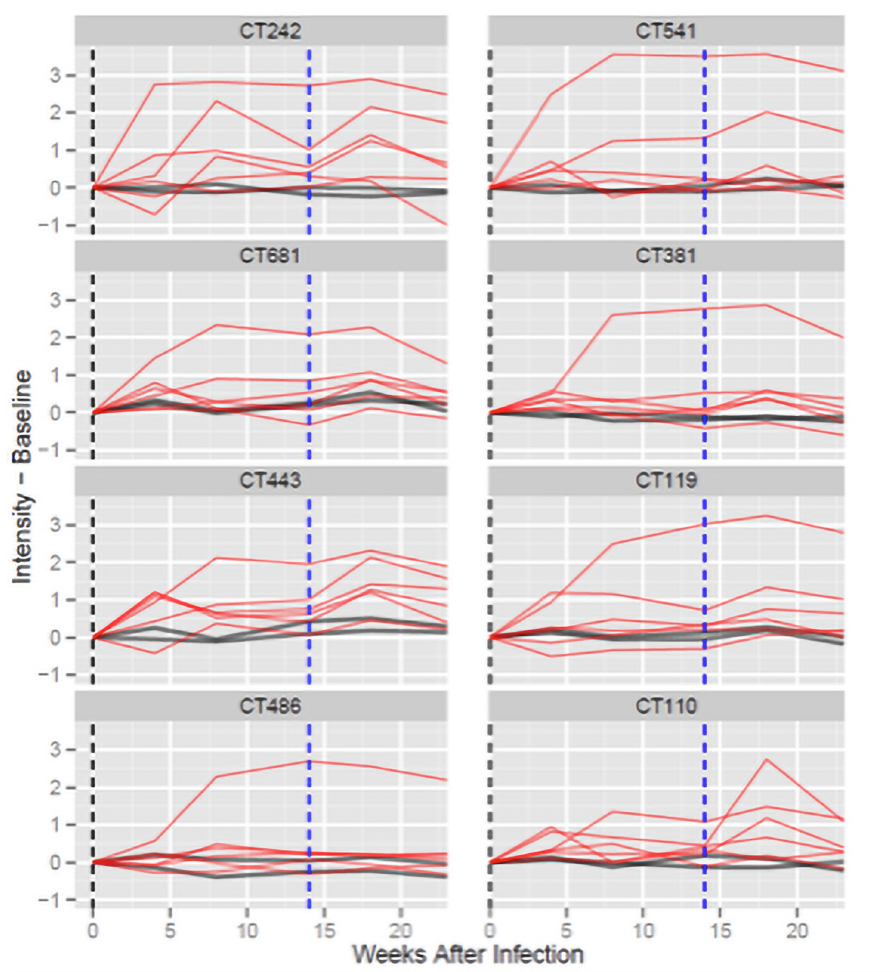
Fig 4. Time course of antibody responses from week 0 to week 23. Each panel presents the time course of antibody responses for one reactive antigen (six monkeys infected at weeks 0 and 14 and mock controls). The x-axis shows the weeks since infection and the y-axis presents the normalized intensity after subtracting the week 0 intensity for each monkey. Infected monkeys are shown with red lines and mock control monkeys are shown with dark gray lines. Vertical dashed lines indicate the first (black: week 0) and second (blue: week 14)